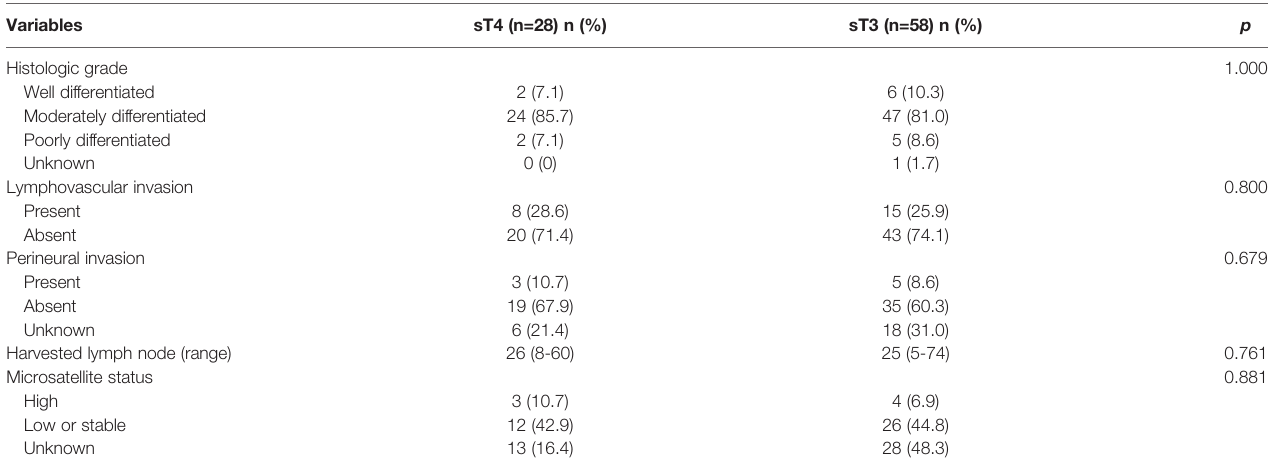
TABLE 3 | Histopathological